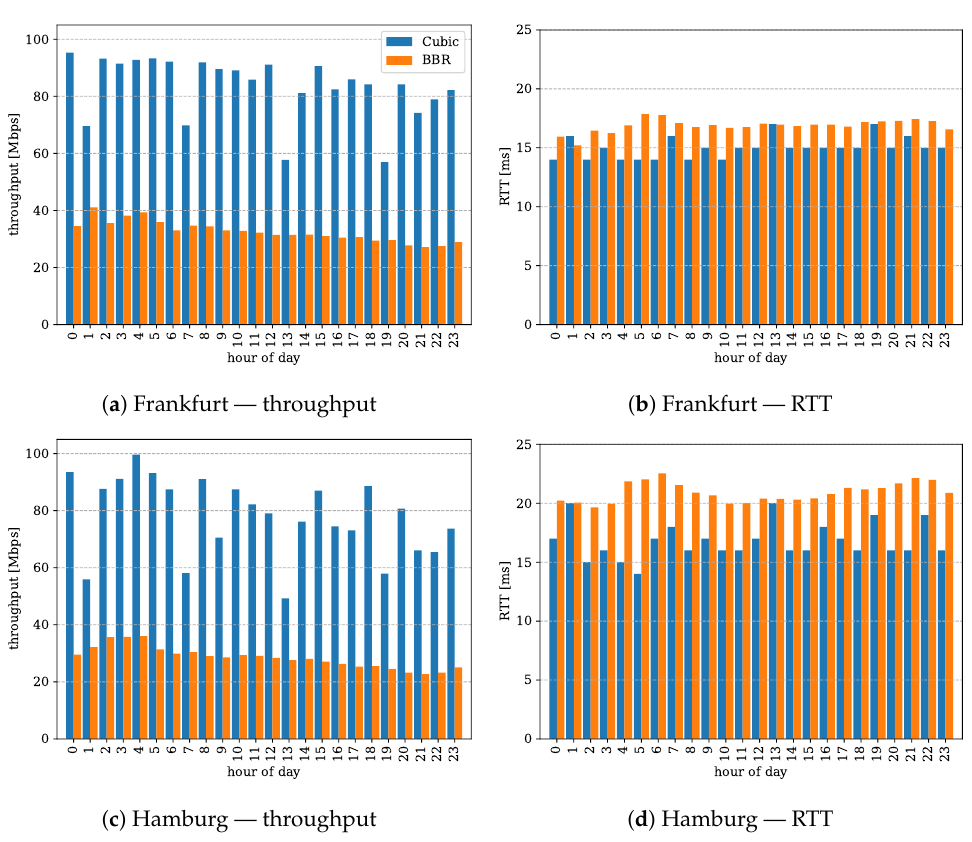
Figure 3. Throughput and RTT per hour of day for August 2021: The performance for TCP BBR follows the pattern of the frequency, during evening hours the performance decreases, after midnight it increases. TCP Cubic shows a significant better performance than TCP BBR, also the periodic pattern at 1 a.m., 7 a.m., 1 p.m., and 7 p.m. is visible where TCP Cubic performs worse. This